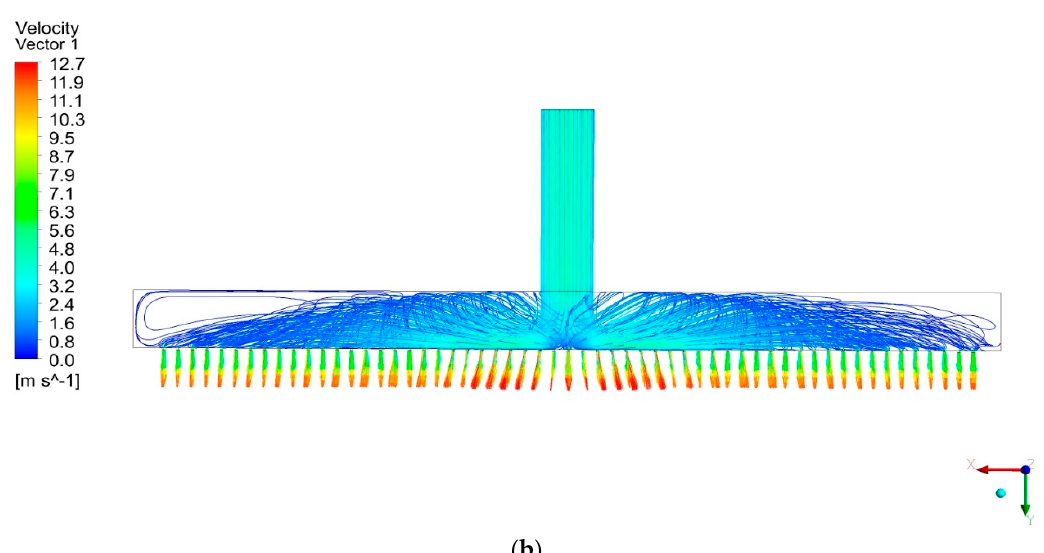
Figure 6. ( a ) Basic gas torch pressure contours; ( b ) inner streamlines and velocity vectors at the outlets.